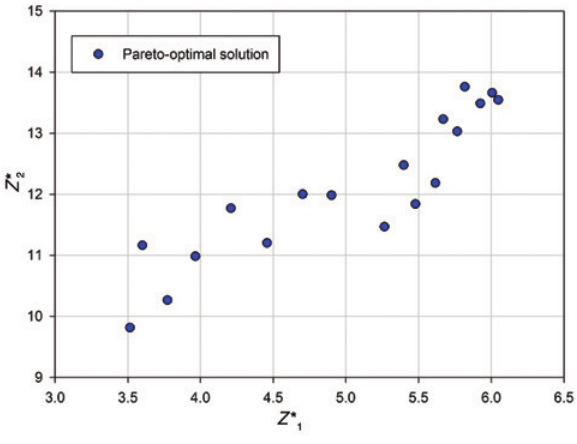
Figure 5: Pareto-Optimal Solutions for the Real Case.